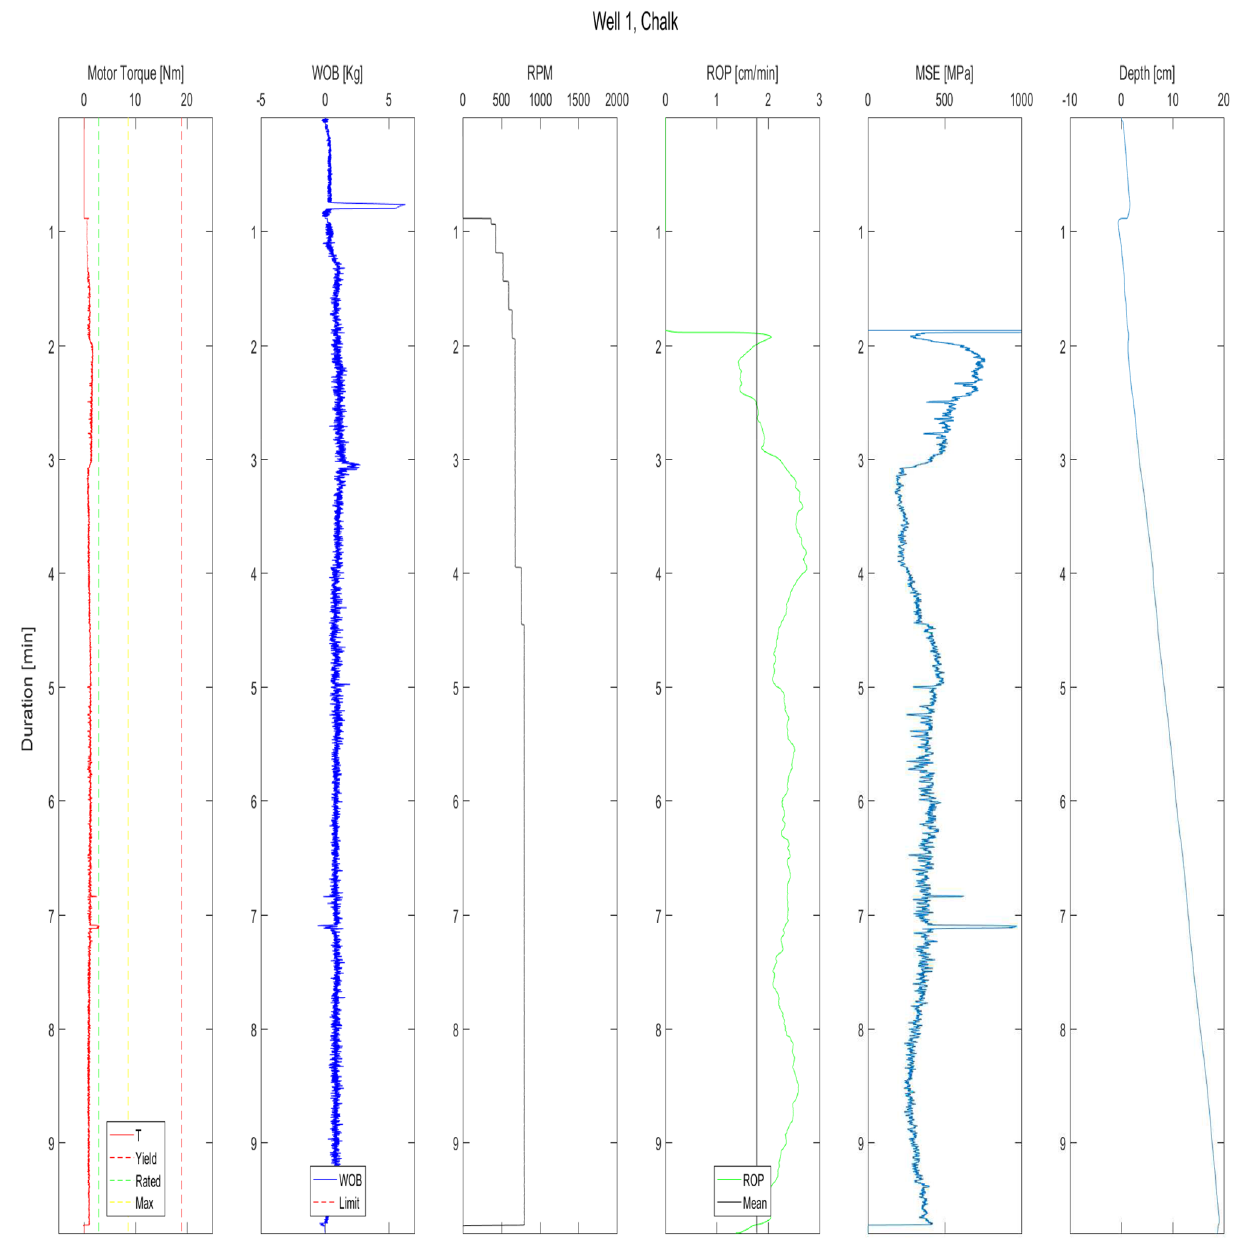
Fig. 5 Well Chalk 1, result of lateral